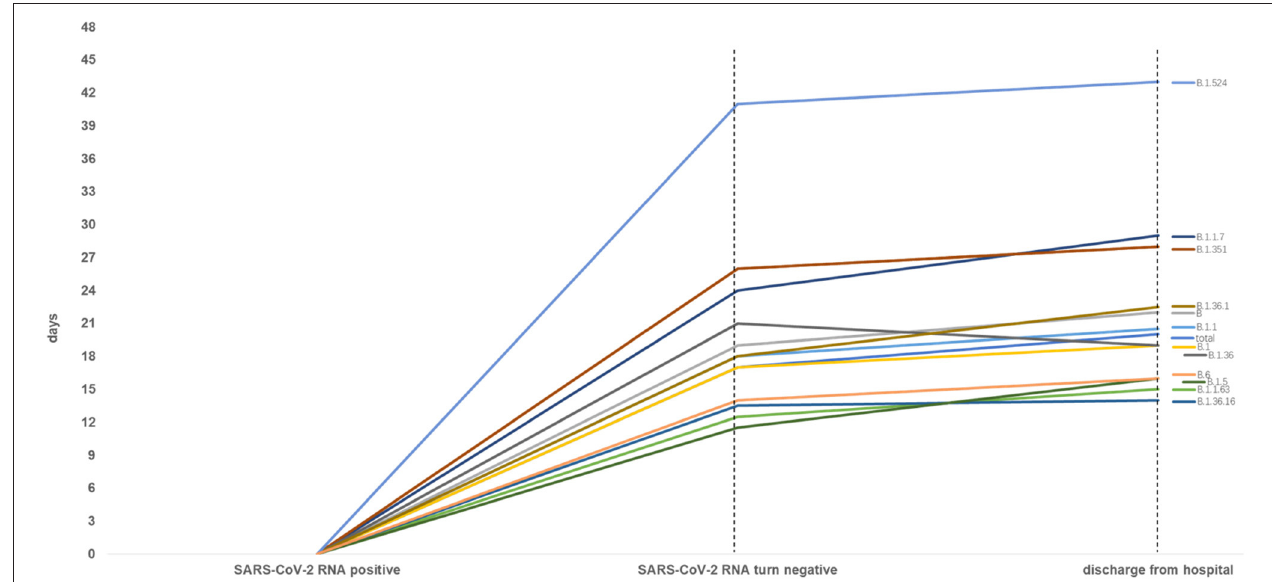
FIGURE 4 | Time from SARS-CoV-2 RNA positive to negative among total and other variants infected patients ( n ≥ 5). Patients with lineage B.1.524 significantly spent longer time in SARS-CoV-2 RNA turning negative and